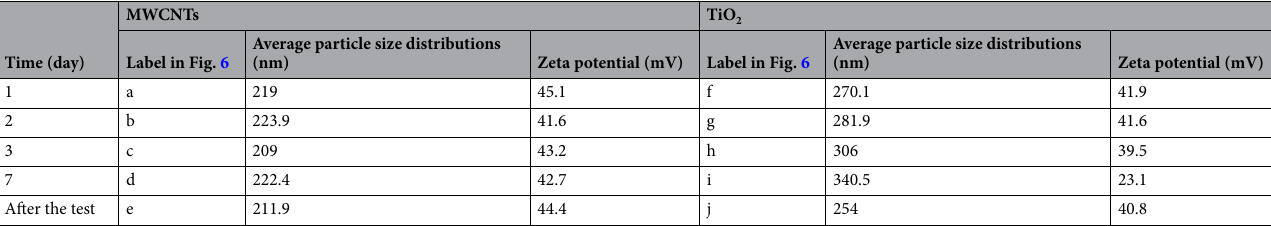
Table 2. Average particle size distribution and zeta potential of nanofluids.